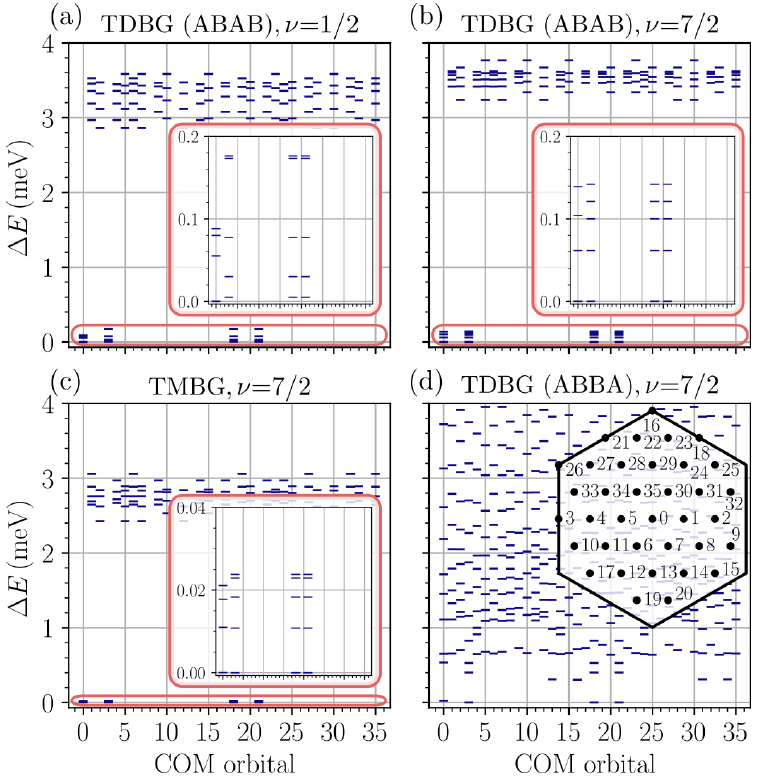
{ w “ 0.9 for (a) AA AB with ν “ 7 { 2 for (b) ABAB int